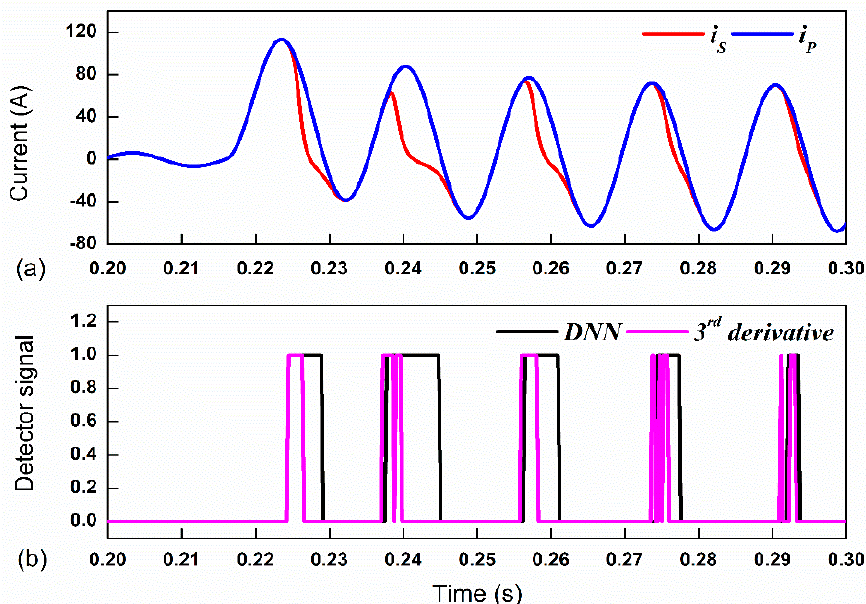
Figure 7. The detection result of CT saturation on the 154-kV (FIA of 0 0 , and remnant flux of 0%). ( a ) Saturated and non-saturated waveform; ( b ) Detection signals.